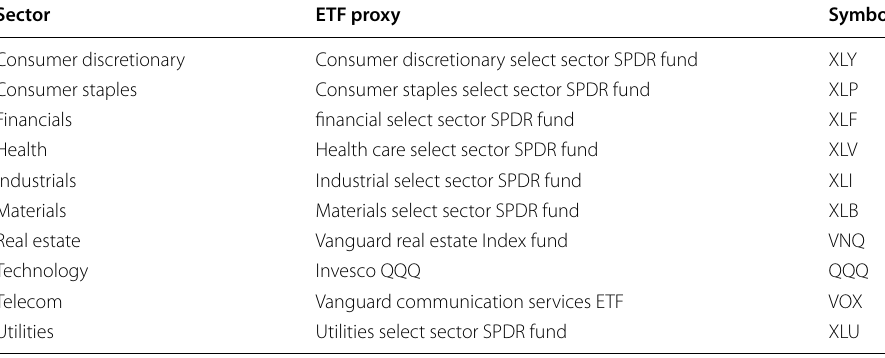
Table 1 Non-energy exchange traded